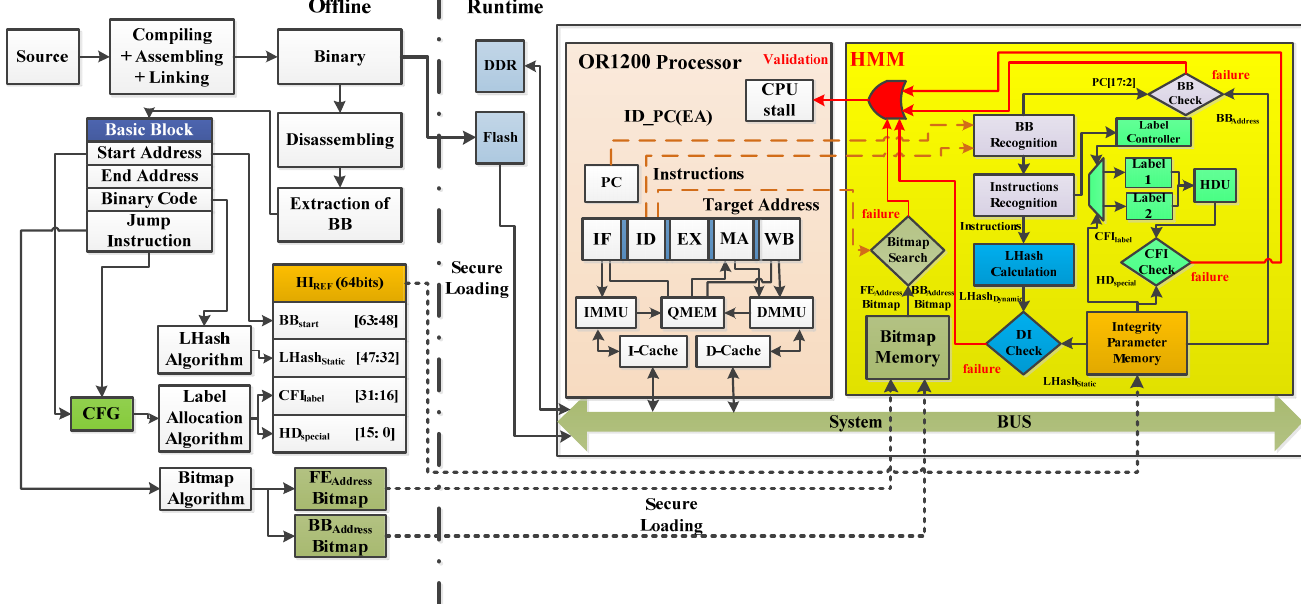
Figure 3. The structure of the Hybrid Information Integrity Monitoring Architecture.